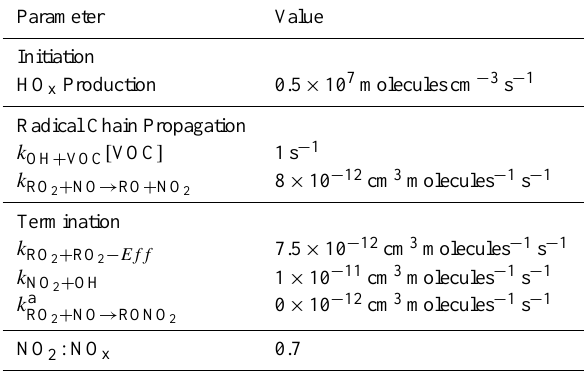
Fig. 1. Steady state OH concentration (left axis) and corresponding × OH) − 1 on the right axis versus boundary NO 2 lifetime ( k NO 2 + OH layer NO 2 column (moleculescm − 2 ) assuming a 1-km well-mixed boundary layer. The color scheme corresponds to regions of high NO 2 (red), where OH is low, intermediate NO 2 (green), where OH is high, and low NO 2 (blue), where OH is low, and is used through- out the